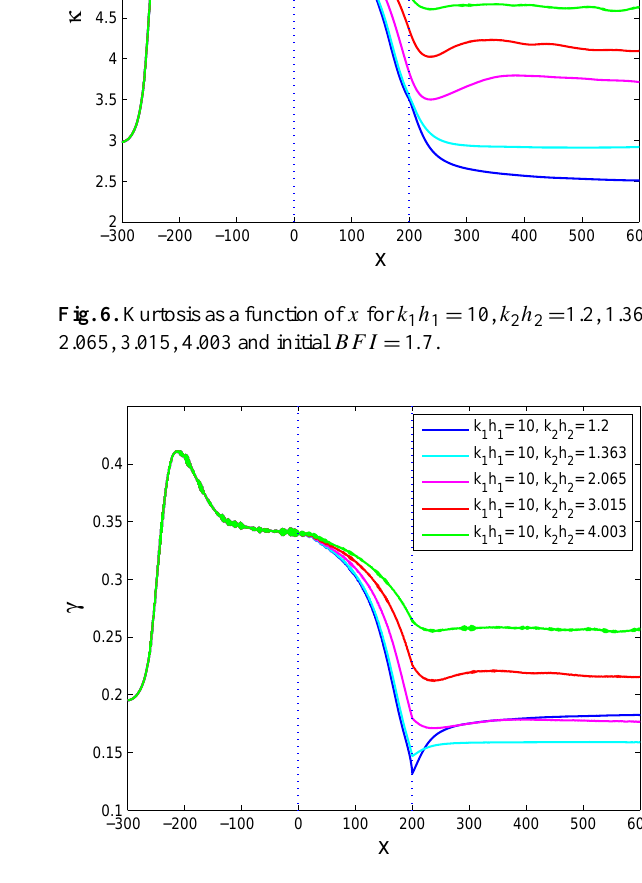
Fig. 7. Skewness as a function of x for k 1 h 1 = 10, k 2 h 2 = 1.2, 1.363, 2.065, 3.015, 4.003 and initial BFI = 1 .